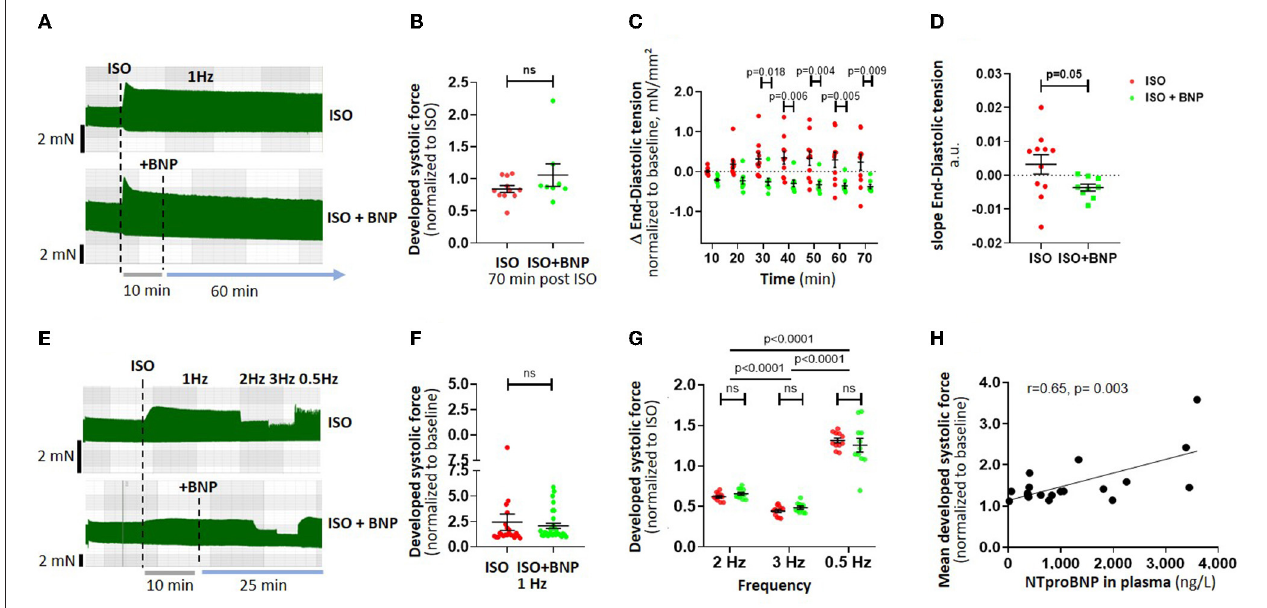
FIGURE 1 | Effect of BNP on atrial inotropy and lusitropy after adrenergic stimulation. Example traces of time-dependent analysis of BNP ( n = 20 strips) are shown in (A) , with the corresponding data on the effect of BNP treatment on atrial systolic force (B) , and end-diastolic tension generation (C) after 70min. The slope of end-diastolic tension over time is shown in (D) . The effects of a frequency-variation protocol [example traces in (E) , n = 40 strips] on systolic force at different stimulation frequencies are shown in (F,G) . Correlation of patient plasma NTproBNP and relative force increase after ISO treatment (values from n = 19 patients with available NTproBNP) is shown in (H) . Data are shown as mean ± SEM; each data point represents one muscle strip. In (H) , each point represents the mean developed systolic force per patient. ISO, isoproterenol; BNP, brain natriuretic